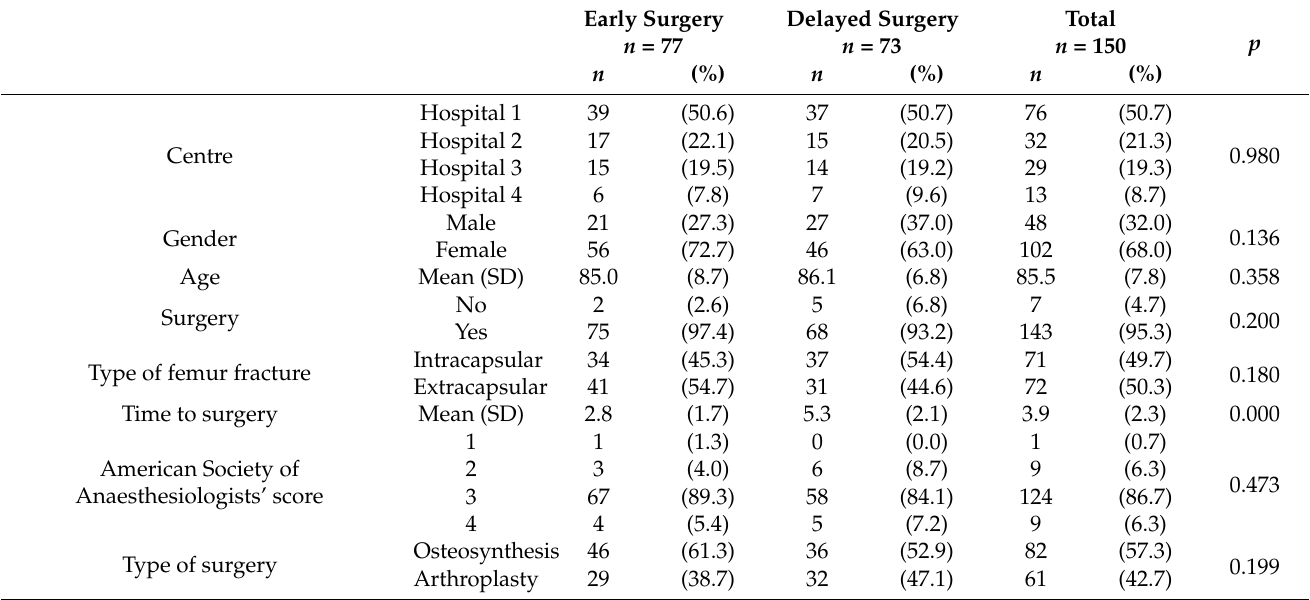
Table 1. Characteristics of the study population randomized and did not withdraw their consent before